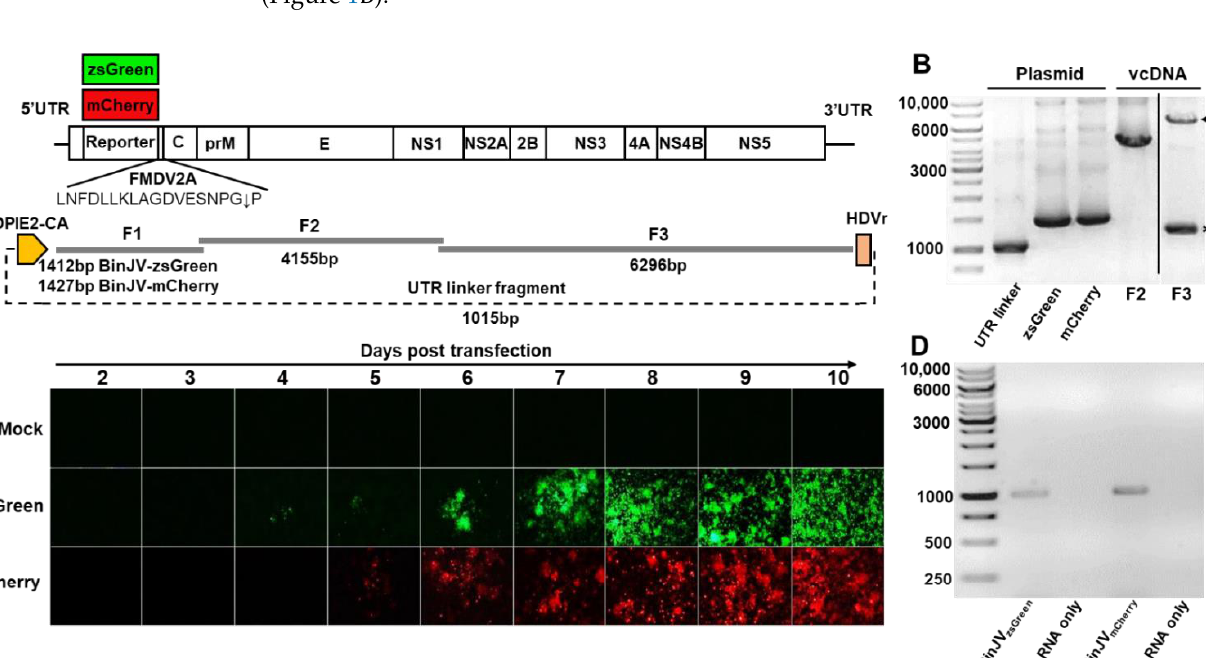
Figure 1. Design and recovery of BinJV reporter viruses. ( A ) Schematics of BinJV and overlapping fragments and linker fragments used for CPER assembly. ( B ) Agarose gel electrophoresis of BinJV fragments amplified from viral cDNA, BinJVzsGreen/mCherry fragments and the UTR linker frag- ment from plasmids. Arrowhead in F3 lane shows correct size band, while asterisk in F3 lane shows non-specific amplification. The image for F3 is from the same gel with unrelated lanes spliced out for clarity. ( C ) Images of zsGreen and mCherry fluorescence of C6/36 cells transfected with reporter virus CPER were taken at 40× magnification daily from two to ten days post-transfection. ( D ) RT-PCR for the reporter insert of P 1 BinJV recombinants propagated in C6/36 cells. RNA-only samples refer to the PCR amplification of RNA samples without the reverse transcription step. Amplicons were generated using RGene_F and RGene_R primers binding to the BinJV sequences flanking the reporter genes.